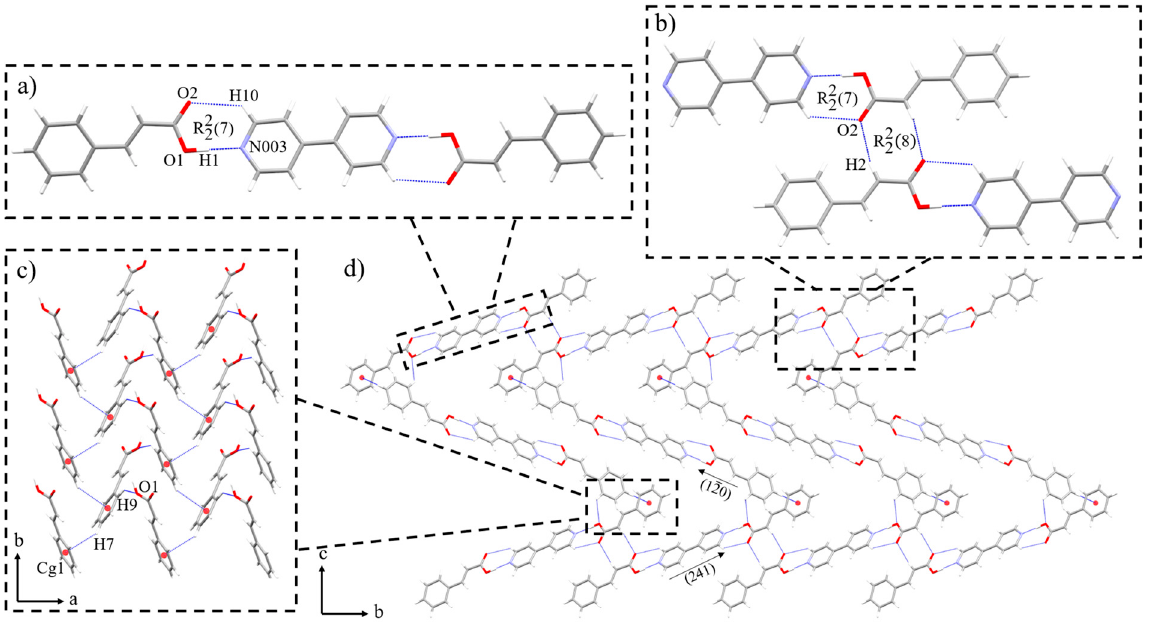
Figure 2. ( a ) Structure of cocrystal (HCinn) 2 (4,4’-bpy) ( 2 ). ( b ) Supramolecular interactions which expand the structure of 2 through the [12 (cid:3364) 0] and [241] directions. ( c ) View along the ab plane of the C-H··· π and C-H···O interactions between HCinn molecules connecting the chains which expand the structure through the [ 12(cid:3364)0] and [241] directions. ( d ) General view of the supramolecular structure of 2 along the bc plane.